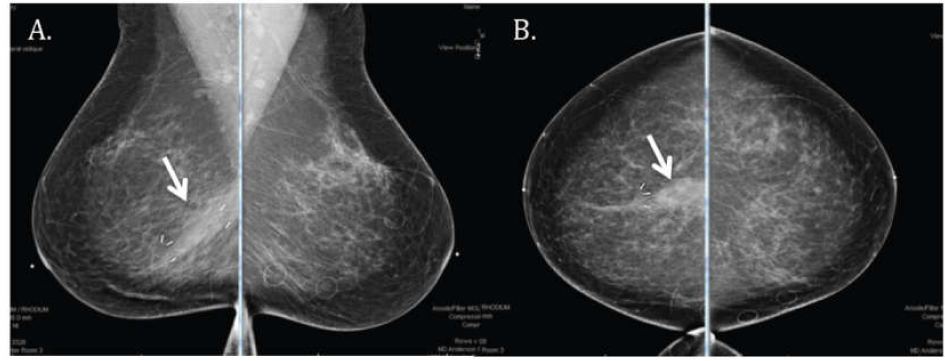
Figure 4. Mammographic evaluation showing ( A ) medio-lateral oblique and ( B ) cranio-caudal views of a common radiologic finding after proton APBI to the right breast at the six-month follow-up visit: post-surgical scar (arrow) and tumor bed